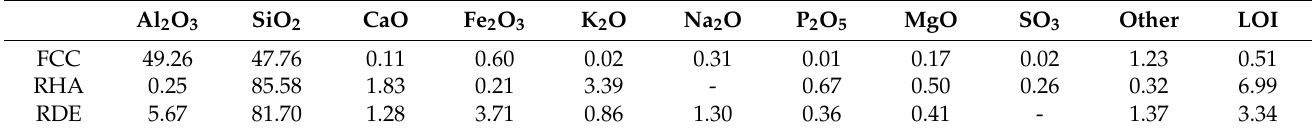
Table 1. Chemical compositions (wt%) of the spent FCC catalyst, RHA and RDE from the beer industry.